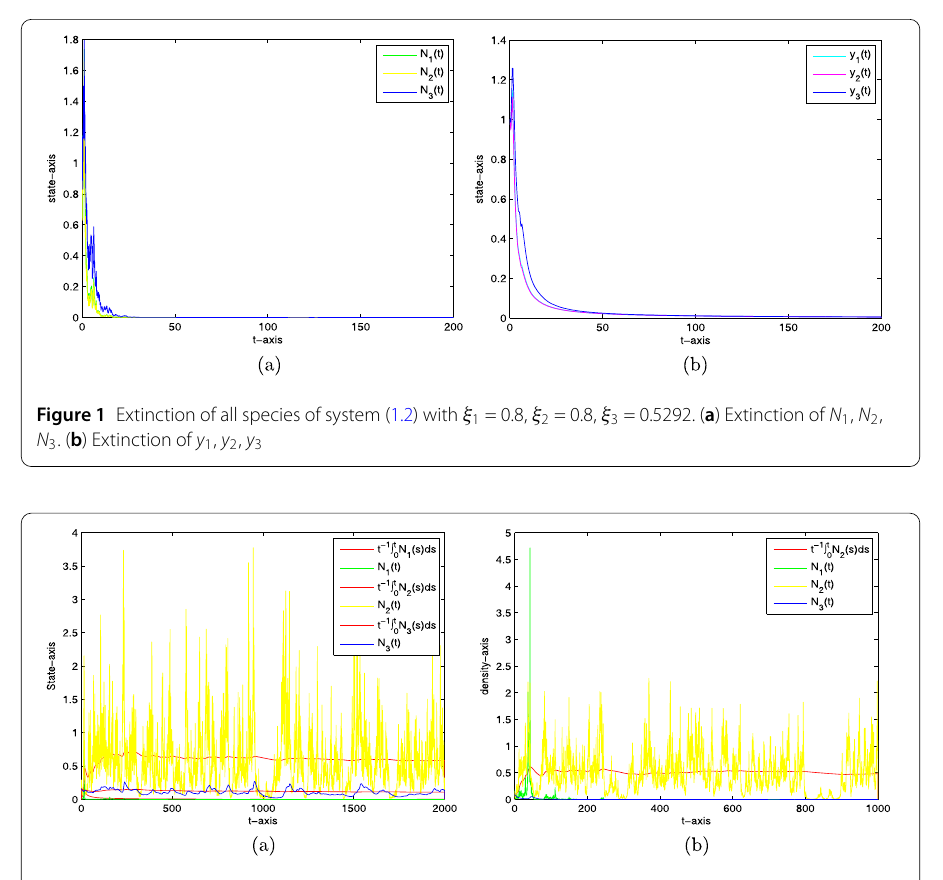
Figure 2 Dynamical behavior of (1.2). ( a ) is for (1.2) with ξ 1 = 0.8, ξ 2 = 0.4, ξ 3 = 0.01, then lim t →∞ N 1 ( t ) = 0, lim t →∞ (cid:8) N 2 ( t ) (cid:9) = 0.5471, lim t →∞ (cid:8) N 3 ( t ) (cid:9) = 0.1118, ( b ) is for (1.2) with r 3 = 0.1, ξ 1 = 0.8, ξ 2 = 0.469, ξ 3 = 0.01, then